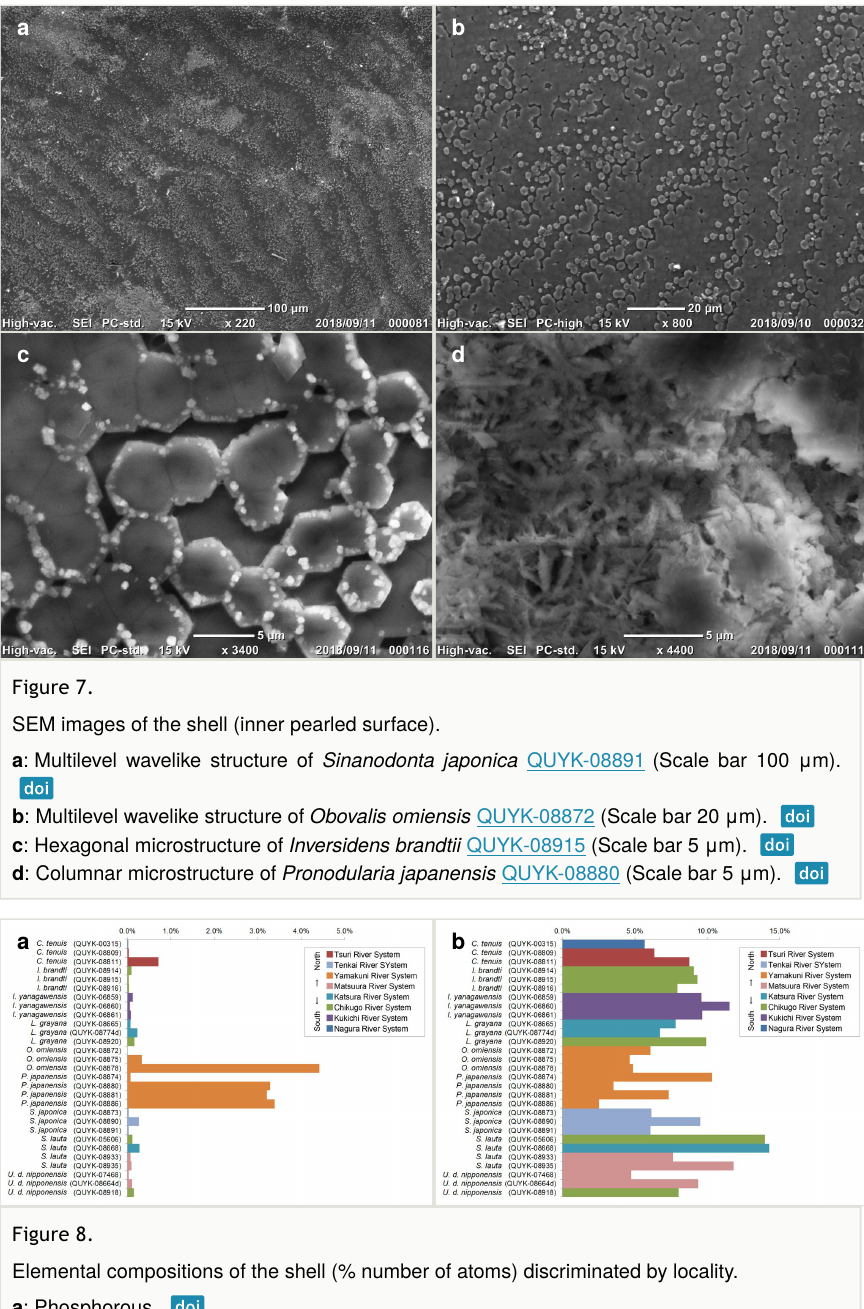
Figure 7. SEM images of the shell (inner pearled surface). a : Multilevel wavelike structure of Sinanodonta japonica QUYK-08891 (Scale bar 100 μ m). b : Multilevel wavelike structure of Obovalis omiensis QUYK-08872 (Scale bar 20 μ m). c : Hexagonal microstructure of Inversidens brandtii QUYK-08915 (Scale bar 5 μ m). d : Columnar microstructure of Pronodularia japanensis QUYK-08880 (Scale bar 5 μ m).